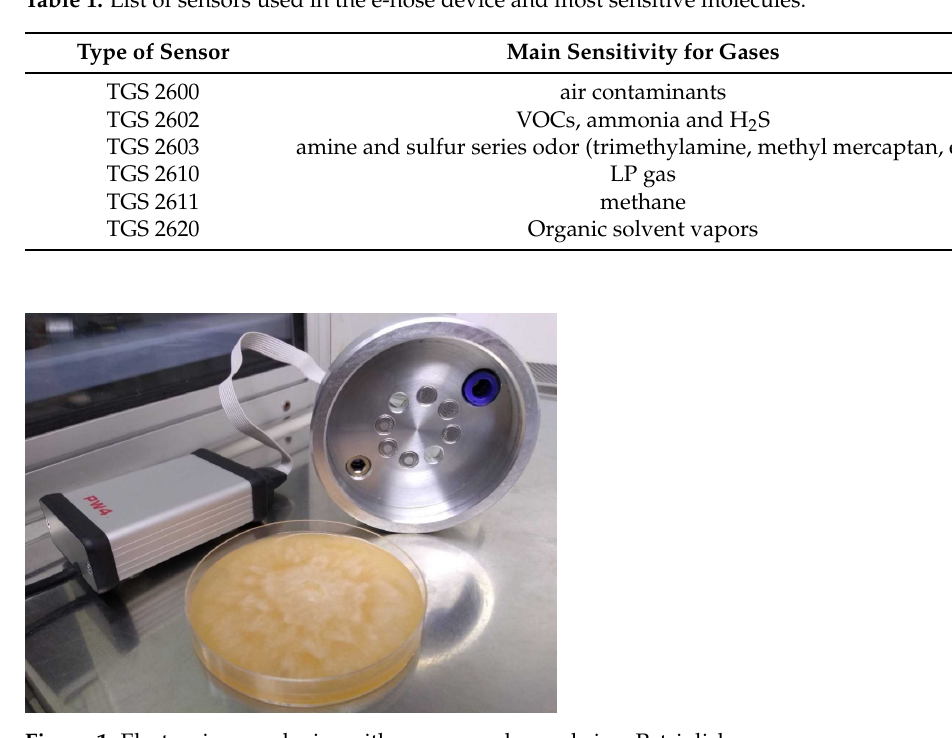
Figure 1. Electronic nose device with a measured sample in a Petri